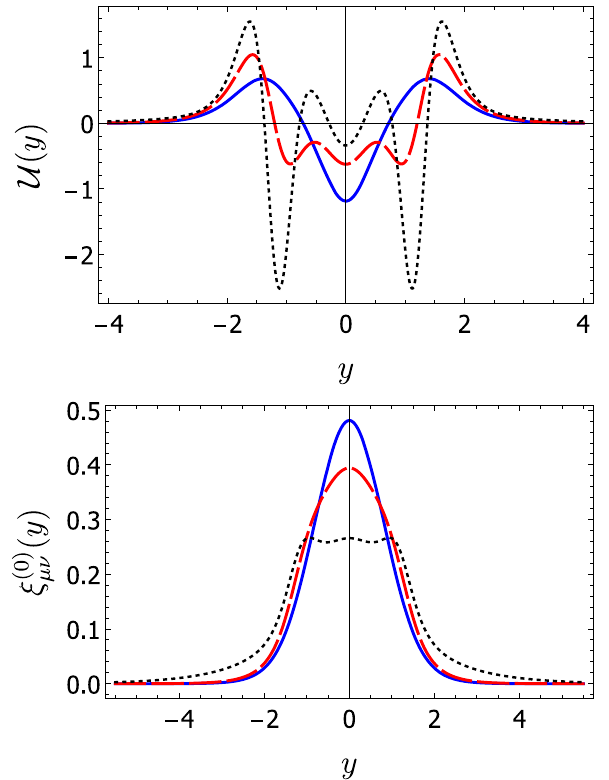
Fig. 6 Stability potential (top panel) and zero mode (bottom panel) depicted for c = 1 . 2 and α = 0 (solid-line), α = 1 (dashed-line) and α = 2